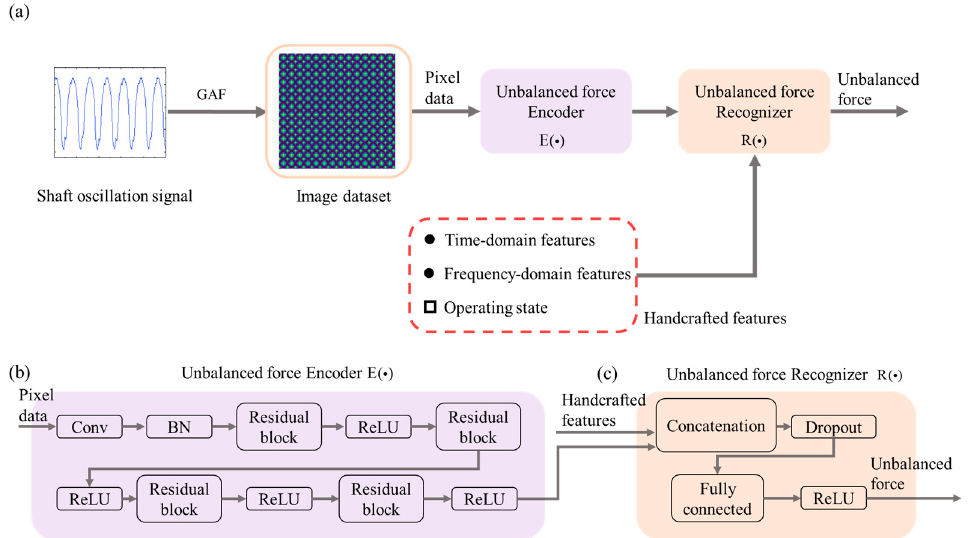
Figure 2. The architecture of the unbalanced force identification model. ( a ) A neural network based on the feature fusion framework. ( b ) The detailed architecture of the encoder. ( c ) The detailed architecture of the recognizer.